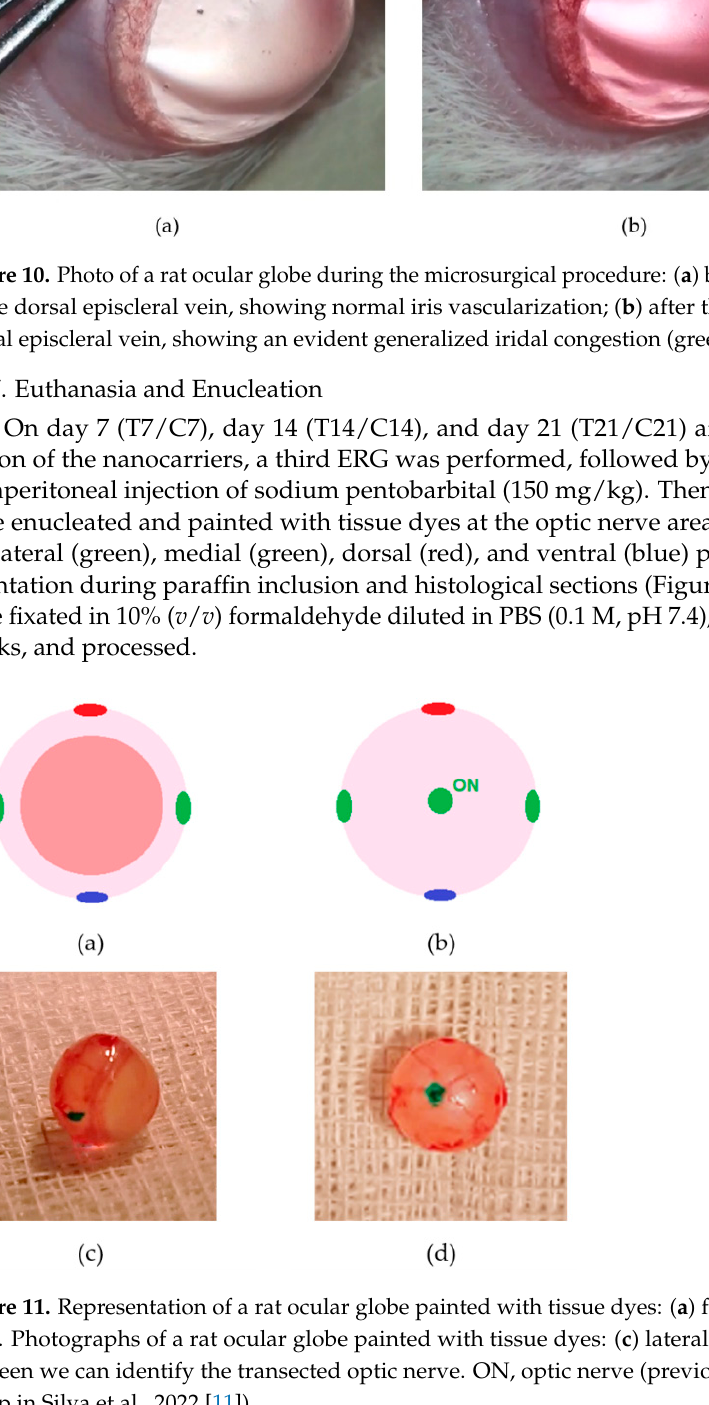
Figure 10. Photo of a rat ocular globe during the microsurgical procedure: ( a ) before the cauteriza- tion of the dorsal episcleral vein, showing normal iris vascularization; ( b ) after the cauterization of the dorsal episcleral vein, showing an evident generalized iridal congestion (green arrow).